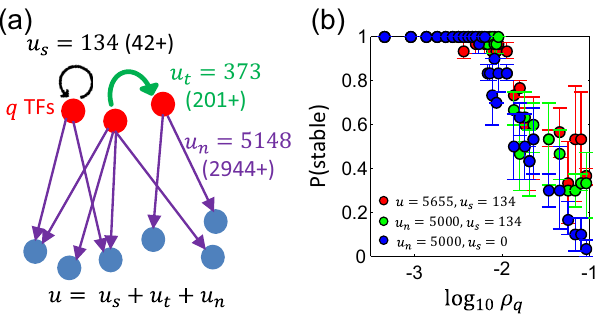
Fig. 5 Effect of density ρ q of transcription factor (TF)-otherTF interactions on stability. a In the real network analyzed, there are u s = 134 self-regulations (of which 42 of them are activating), u t = 373 TF-other TF interactions (of which 201 of them are activating), and u n = 5148 TF-nonTF interactions (of which 2944 of them are activating). The total number of interactions is given by u . b A randomly constructed network is almost always stable when ρ q is suf fi ciently low. Above a threshold value, the probability of being stable (P(stable)) decreases with ρ q . This is true with (red and green circles) or without (blue circles) self-interactions, and regardless of whether it is the total number of interactions u (red circles) or the number of TF-nonTF interactions u n (green and blue circles) that is kept constant. Each data point is an average over 15 sets of 10 regulatory networks, with error bars indicating the interquartile range. [Parameters: N = 2274, q = 211, h = 2, Ω max ¼